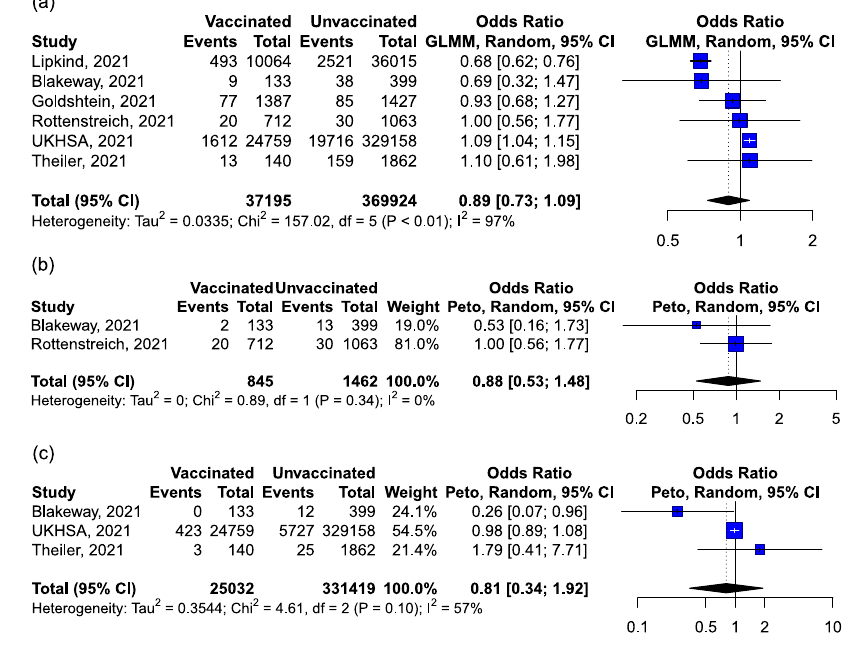
Fig. 5 Forest plot of studies reporting on preterm birth rate prior to 37 weeks' (a), 34 weeks' (b) and 32 weeks' (c) gestation. Vertical ticks within the blue boxes and horizontal lines show the mean effect and 95% con fi dences interval for each study. Black diamond at the bottom shows the cumulative effect with 95% con fi dence intervals.